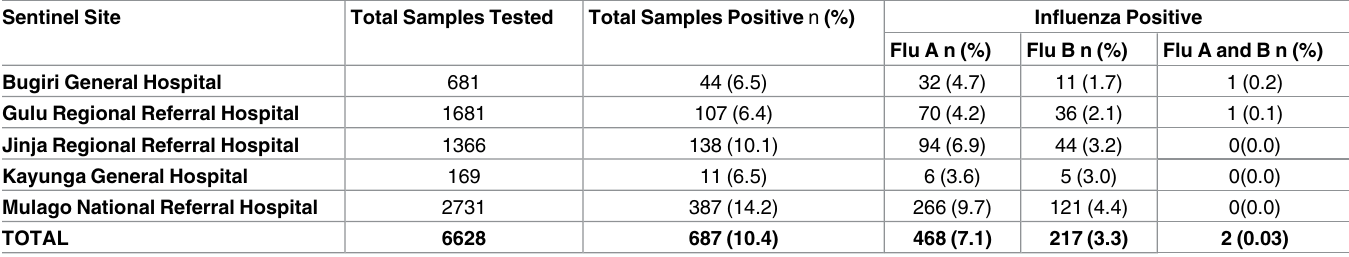
Table 2. Period Prevalenceof Influenza by Type and Surveillance Site